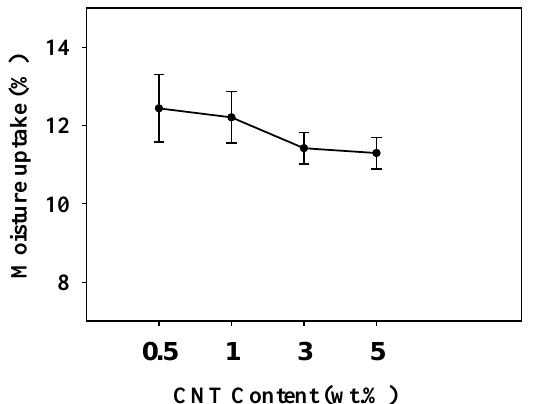
Figure 10. Moisture uptake of PULL/TOCNs/CNT-based nanocomposite films.